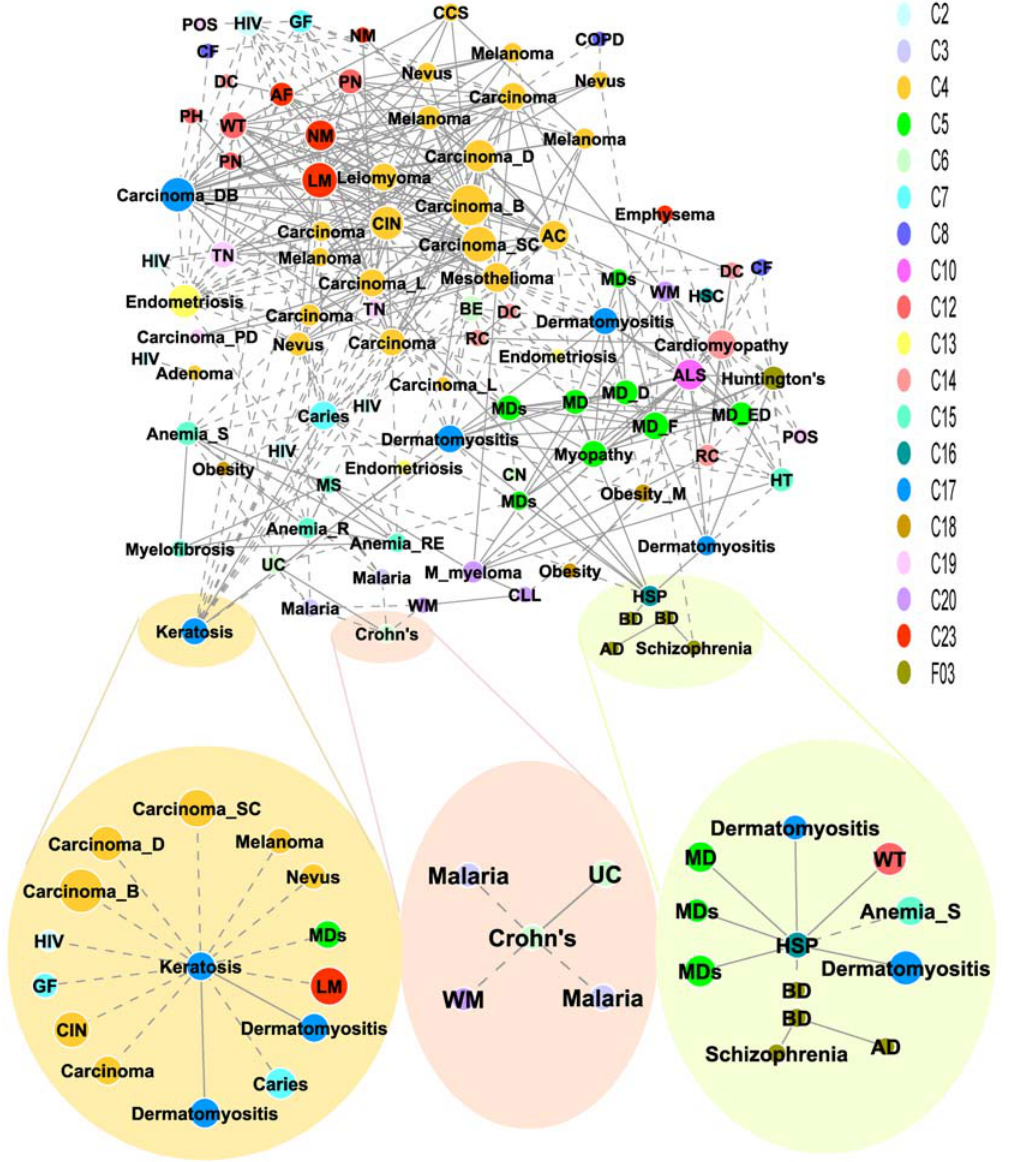
Figure 1. Human disease network. In the disease network, each node corresponds to a disease colored according to their MeSH disease category as denoted by the MeSH Tree Number as shown on the right panel. The size of each node is proportional to the number of diseases connecting to it. A solid line links two diseases from same MeSH disease category while the dot line links two diseases from different MeSH disease category. Multiple nodes may represent the same disease, but they are from different studies or conditions, e.g. there are two bipolar disorder nodes, whose profiles are derived from studies using two different tissues (dorsolateral prefrontal cortex tissue and orbitofrontal cortex tissue). Disease abbreviations used in this figure include: C02, virus disease; C03, parasitic diseases; C04, neoplasms; C05, musculoskeletal diseases; C06, digestive system diseases; C07, stomatognathic diseases; C08, respiratory tract diseases; C10, nervous system diseases; C12, male urogenital diseases; C13, female urogenital diseases and pregnancy complications; C14, cardiovascular diseases; C15, hemic and lymphatic diseases; C16, congenital hereditary neonatal diseases and abnormalities; C17, skin and connective tissue diseases; C18, nutritional and metabolic diseases; C19, endocrine system diseases; C20, immune system diseases; C23, pathological conditions signs and symptoms; F03, mental disorders; AC, adenocarcinoma; AD, Alzheimer disease; AF, atrial fibrillation; ALS, amyotrophic lateral sclerosis; Anemia_R, refractory anemia; Anemia_RE, refractory anemia with excess of blasts; Anemia_S, sideroblastic anemia; BD, bipolar disorder; BE, Barrett esophagus; Carcinoma_B, basal cell carcinoma; Carcinoma_D, ductal carcinoma; Carcinoma_DB, breast ductal carcinoma; Carcinoma_L, lobular carcinoma; Carcinoma_PD, pancreatic ductal carcinoma; Carcinoma_SC, squamous cell carcinoma; CCS, clear cell sarcoma; CF cystic fibrosis; CIN, cervical intraepithelial neoplasia; CLL, chromic lymphocytic leukemia; CN, colorectal neoplasms; COPD, chronic obstructive pulmonary disease; DC, dilated cardiomyopathy; GF, gingival fibromatosis; HSC, hemoglobin sickle cell disease; HSP, hereditary spastic paraplegia; HT, hemorrhagic thrombocythemia; LM, lymphatic metastasis; M_myeloma, multiple myoloma; MD, muscular dystrophy; MD_D, Duchenne muscular dystrophy; MD_ED, Emery-Dreifuss muscular dystrophy; MD_F, Facioscapulohumeral muscular dystrophy; MDs, muscular diseases; MS, myelodysplastic syndromes; NM, neoplasm metastasis; Obesity_M, morbid obesity; PH, prostatic hyperplasia; POS polycystic ovary syndrome; RC, restrictive cardiomyopathy; TN, thyroid neoplasms; UC, ulcerative colitis; WM, waldenstrom macroglobulinemia; WT, Wilms tumor.